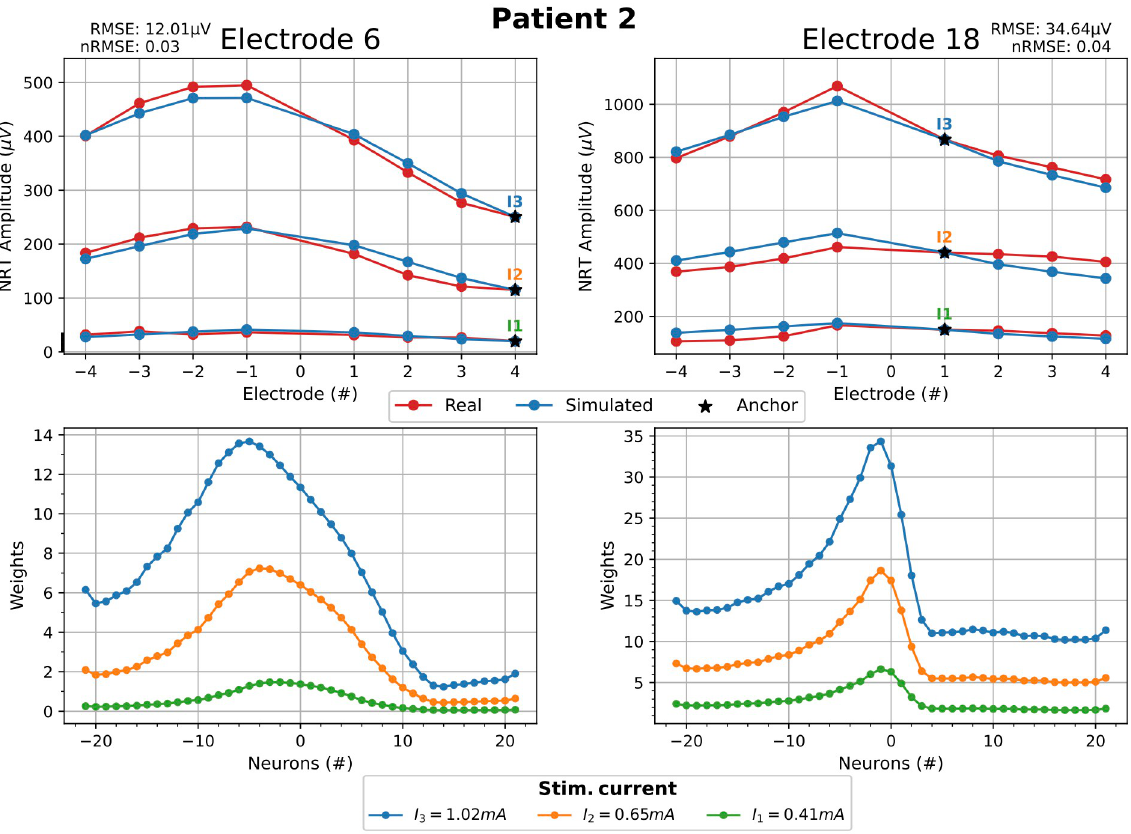
Fig 11. Fitting with optimal anchor. Real and computed NRT amplitudes for the patient 2 choosing the optimum anchor. The global and normalized RMSE of data fitting are shown at the upper row of pictures. Corresponding weights � w 4 the bottom row of